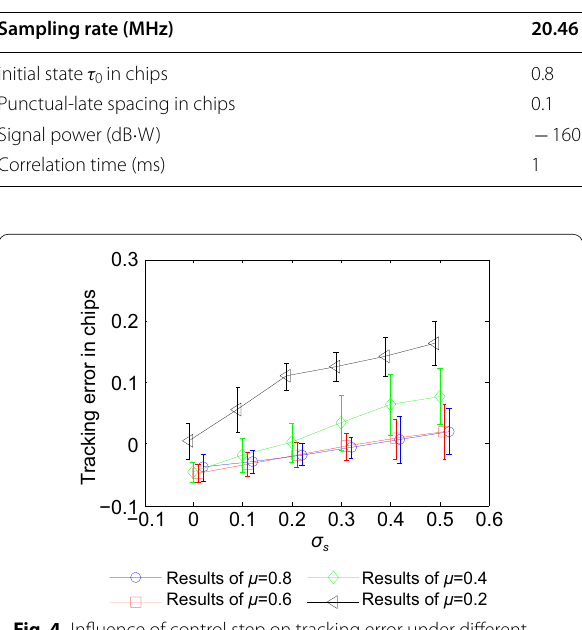
Fig. 4 Influence of control step on tracking error under different